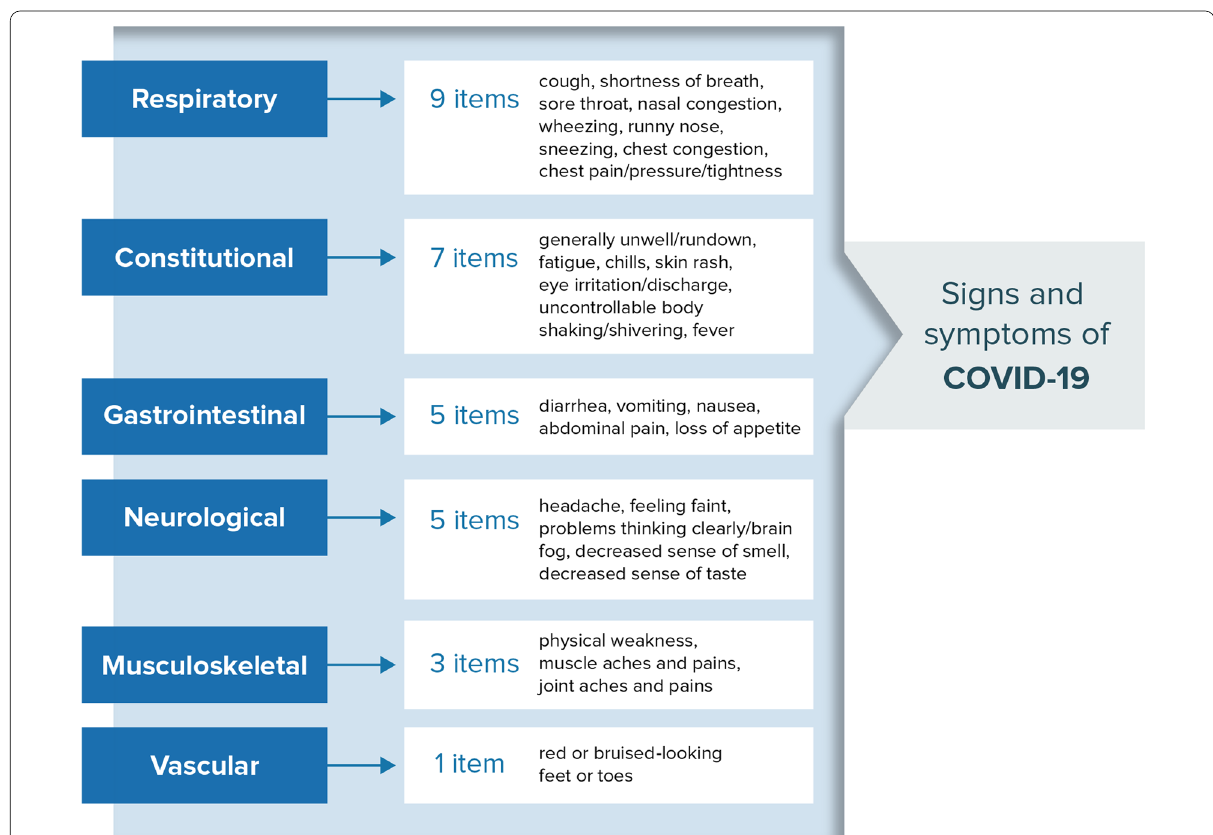
Fig. 2 Draft SIC Conceptual Framework. A set of SIC candidate composite scores describing the impact of COVID-19 on different body systems (constitutional, gastrointestinal, musculoskeletal, neurological, sensory, respiratory, upper and lower respiratory) were chosen after performing well